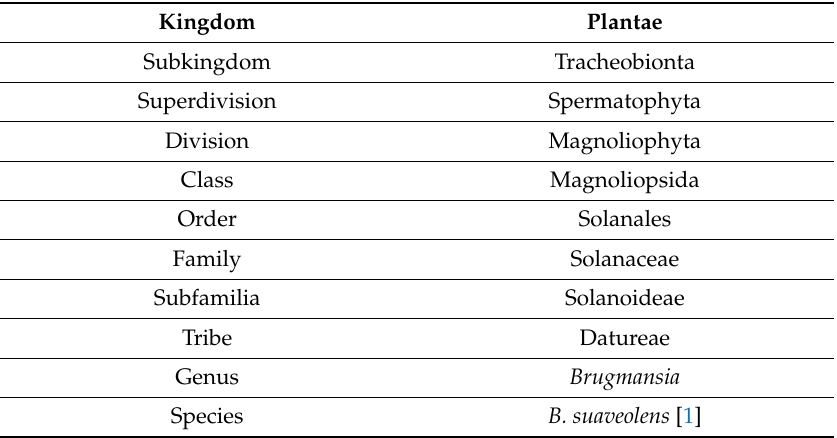
Table 1. Taxonomical classification of Brugmansia suaveolens